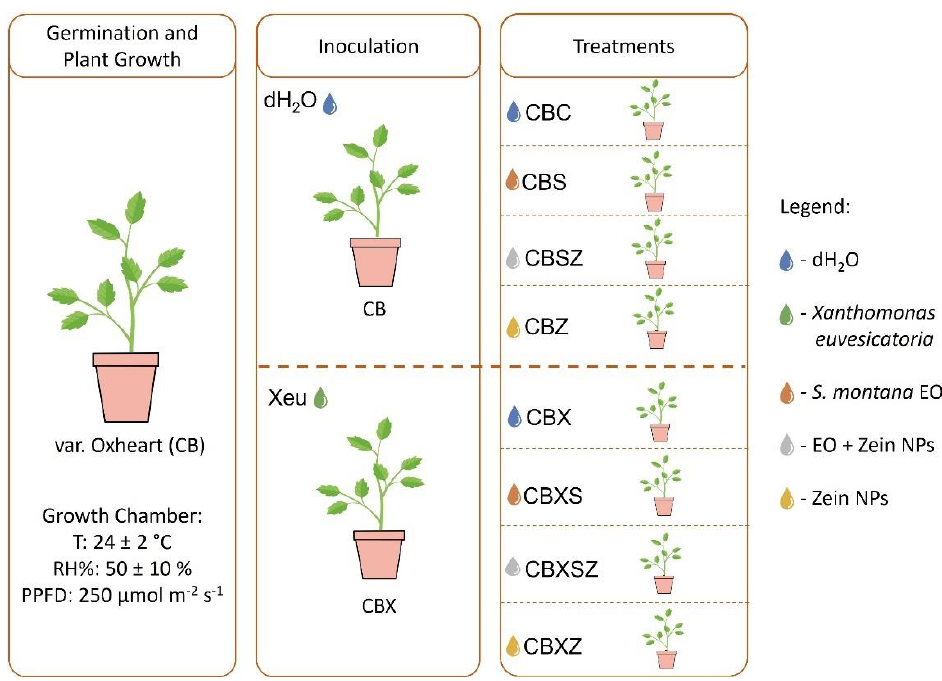
Figure 1. Schematic representation of the treatments applied to tomato plants. X. euvesicatoria LMG 905 were grown at 28 ◦ C in yeast extract-dextrose-CaCO 3 (YDC) medium. Infection was carried out in 45-day-old plants by inoculation with 4 mL of a suspension of X. euvesicatoria (LMG 905) at and optical density ( λ = 600 nm) of 0.25. The bacterial suspension was applied by spraying both leaf sides with a spray vial.